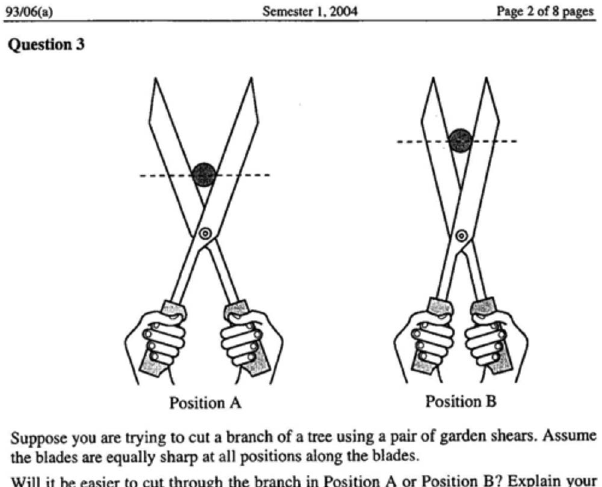
FIG. 4. Example of a past exam question handed out and worked on in class.